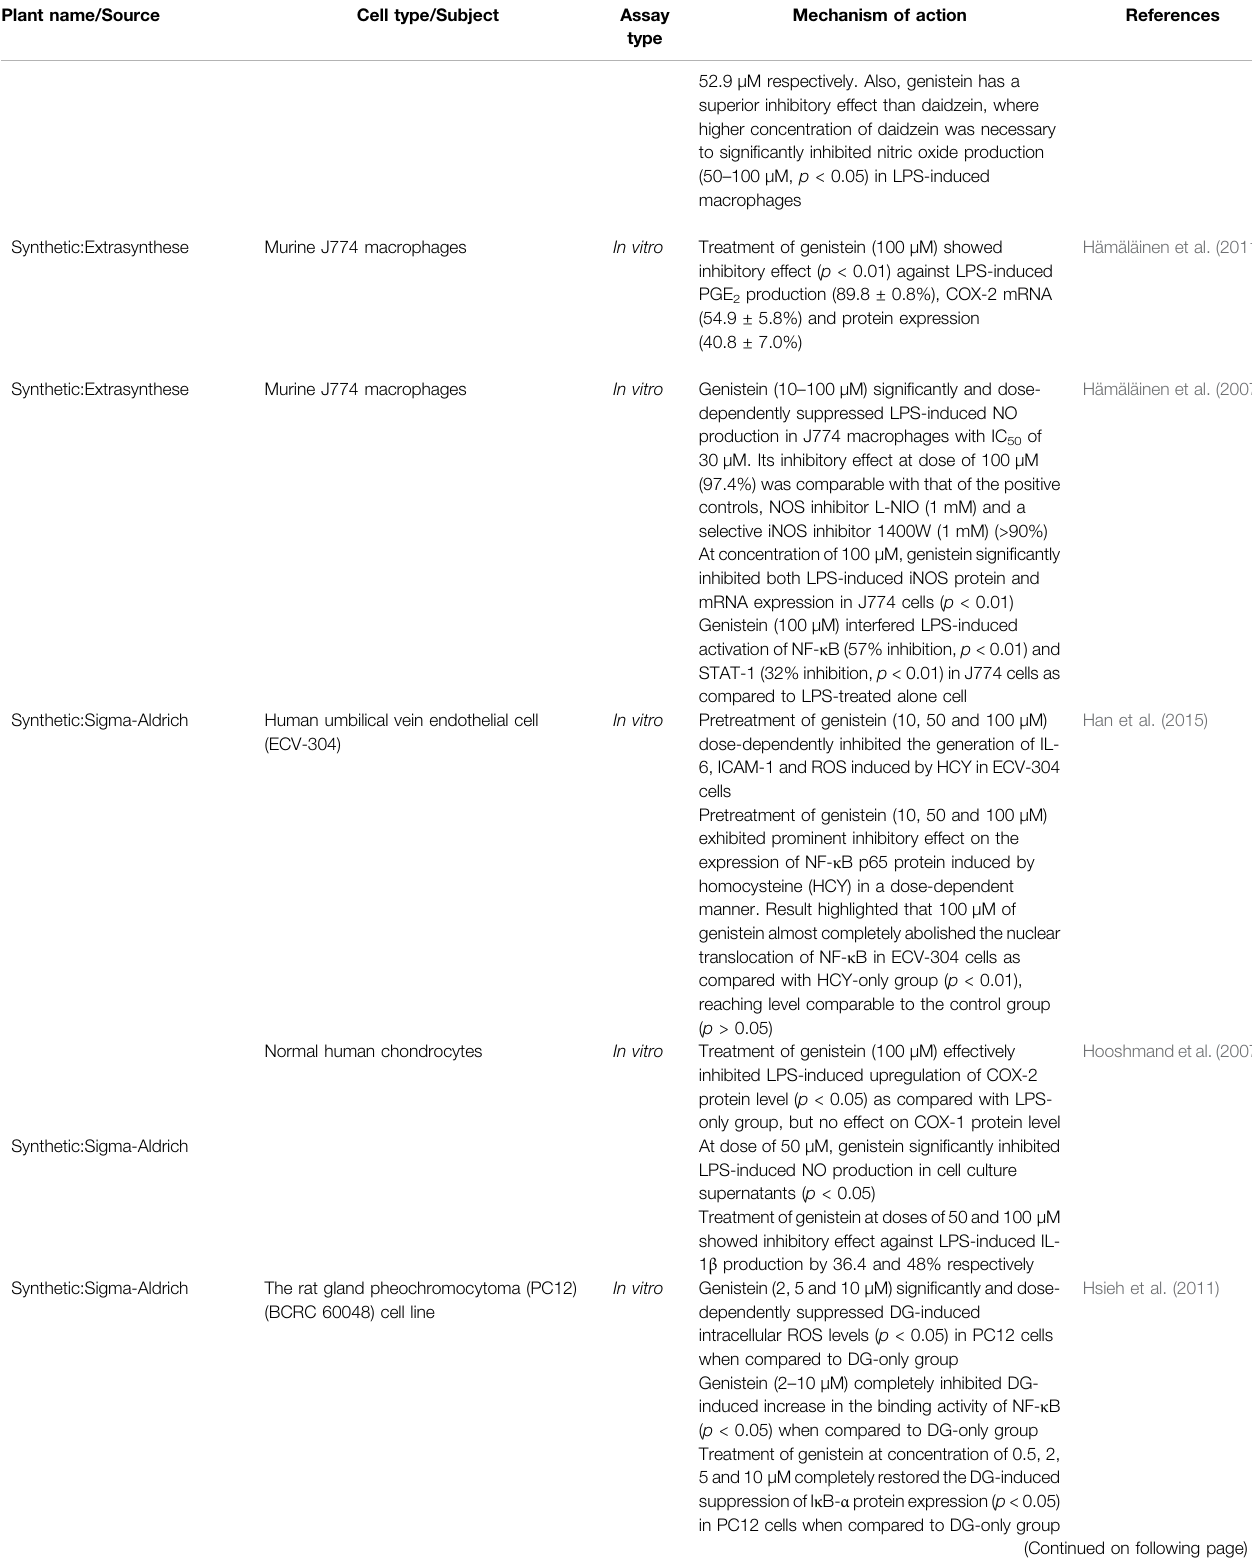
TABLE 1 | ( Continued ) Genistein with potent anti-in fl ammatory